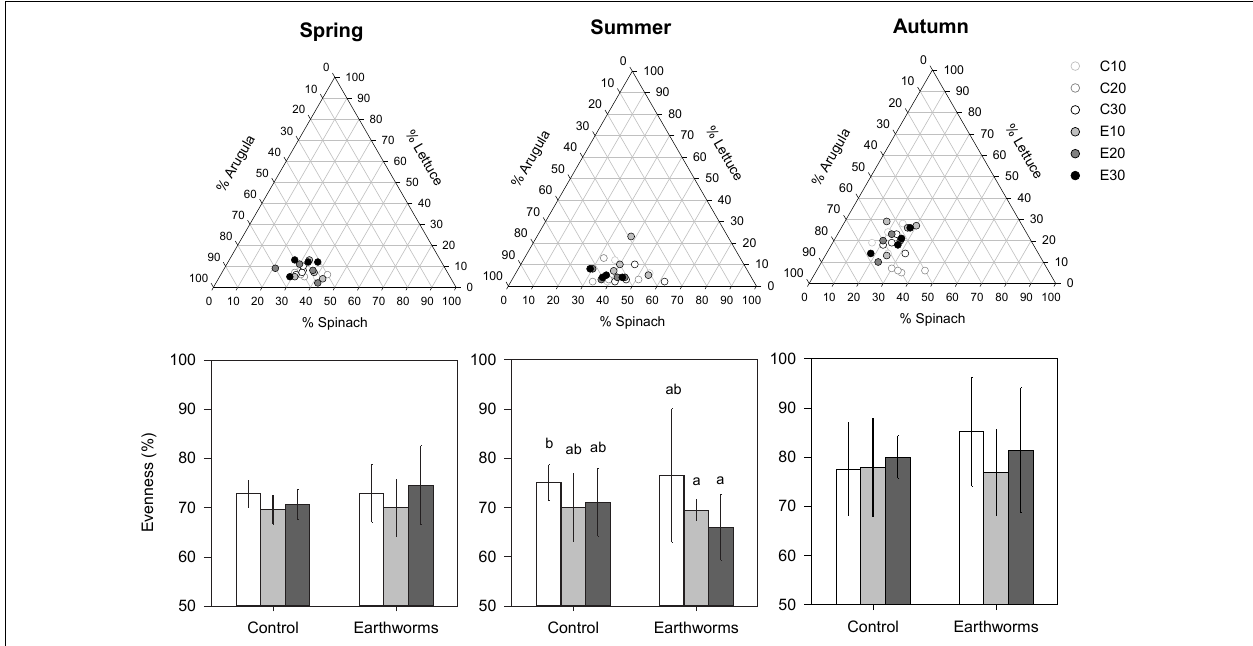
FIGURE 2 | Proportion of lettuce, rocket and spinach biomass obtained in co-culture at each season (spring, summer, and autumn) as function of the compost proportion in Technosols with (E10, E20, E30) or without (C10, C20, C30) earthworms (upper triangles). The biomass evenness is indicated below. The error bars are the standard errors of the mean ( n = 4). Different letters above the histogram indicate significant differences ( P < 0.05) between